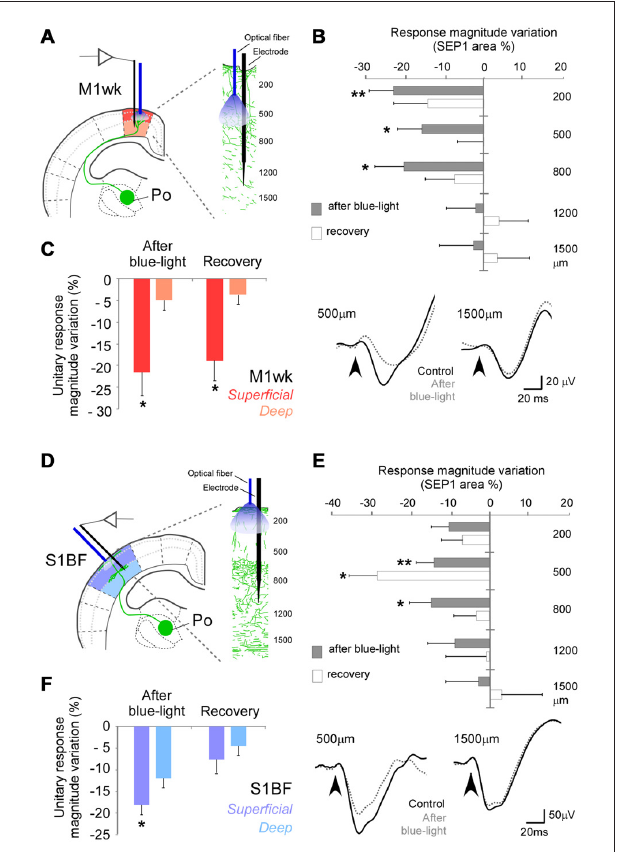
FIGURE 7 | Optogenetic activations of Po terminal axons focused on M1wk layer 3 or on S1BF layer 1 modify subsequent tactile stimulus processing in other cortical layers. (A) Diagram of the M1wk experimental protocol. Mechanical stimuli (air puffs) were applied to the trimmed contralateral whiskers (three trains of 100 stimuli, 1 Hz). A single long-lasting pulse of blue-light (473 nm, 300 ms, < 30 mW/mm 2 ) was applied through a fiber optic whose tip was positioned in L3M1wk, pointing inwards to illuminate Po axons terminals expressing ChR2 + eYFP in this layer. The light pulse was applied immediately after the first train (“control”) of whisker stimuli. SEPs and unit responses were recorded separately in the superficial and deep layers (shaded in different color hues, respectively). (B) L3 Po terminal axons activation modified SEP1 in others M1wk cortical layers. Changes in SEP1 area immediately after light application (gray) and during the recovery train (white) are represented as the variation of percentage to the control values at different depths. Negative values symbolize inhibition and positive values facilitation. Representative traces examples of SEPs recorded during control (black line) and after light application (gray dashed line) trains are shown below. (C) Blue-light activation of Po terminal axons in L3 of M1wk modulates unit responses and more superficially located layers. Mean values of changes in unit responses are represented as the variation of spike counts percentage to the control train. (D) Diagram of the S1BF experimental protocol. A single long-lasting pulse of light was applied through a fiber optic whose tip was placed in L1 S1BF, pointing inwards. Others conventions as in panel (A) . (E) Light-activation of thalamocortical Po axons in L1 changes subsequent SEP1 recorded in others cortical layers. Conventions as in panel (B) . (F) Light activation of Po terminal axons in L1 S1BF modify unit responses in both superficial and deep layers. Conventions as in panel (C)